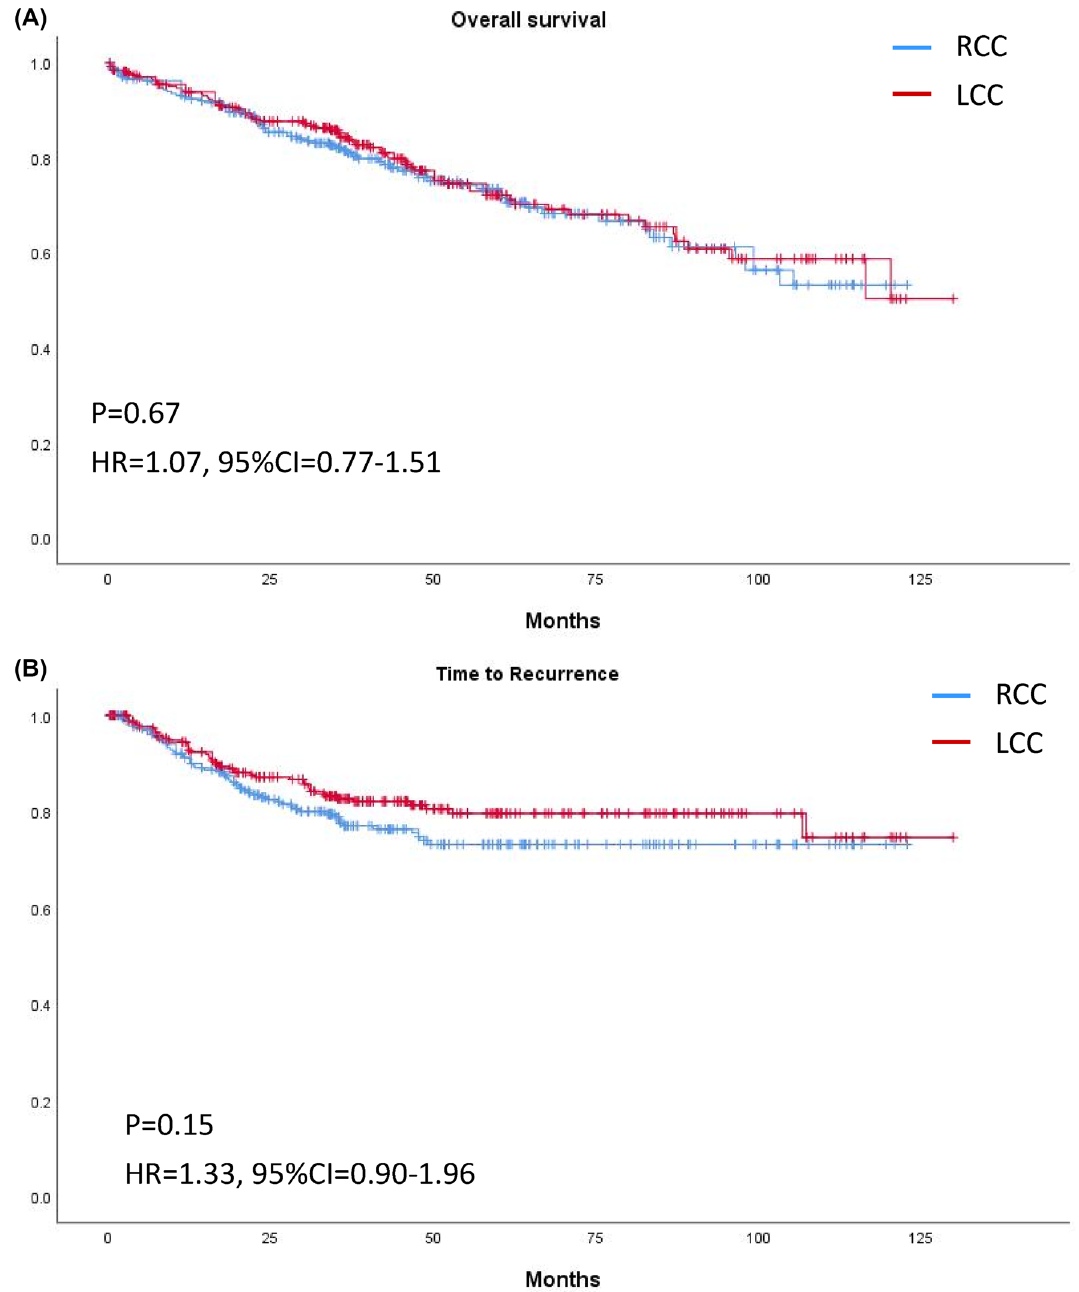
Figure 5. Kaplan–Meier curves of ( A ) overall survival and ( B ) time to recurrence of right-sided and left-sided colon cancer of any stage after